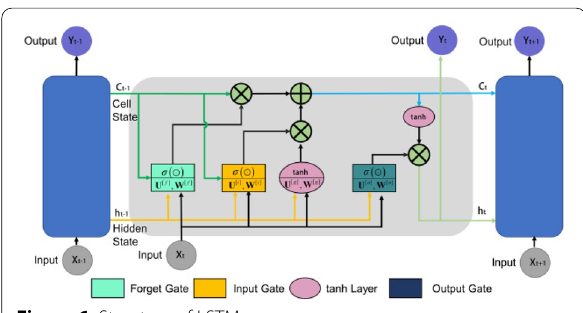
Figure 6 Structure of